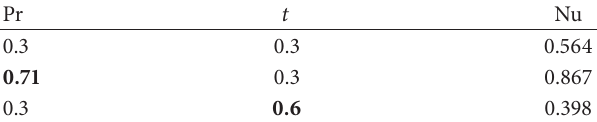
Table 2: Nusselt number